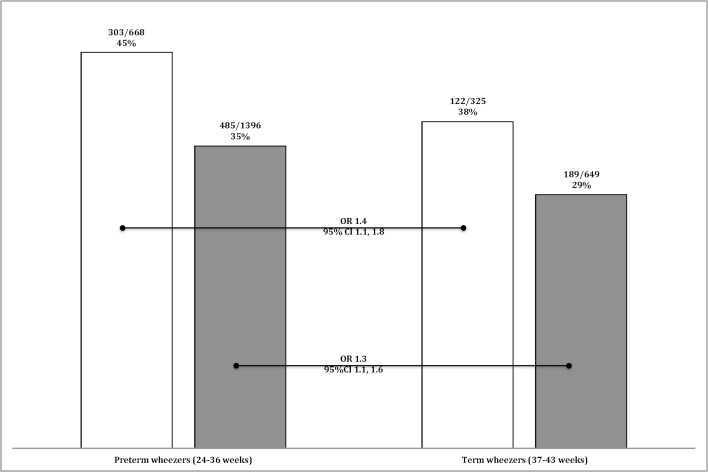
Prevalence of inhaler treatment amongst wheezing children.Bars denote the percentage of wheezy children being treated with inhalers who have a family history of atopy (white bars) or not (black bars) and for both gestational groups, preterm or term.